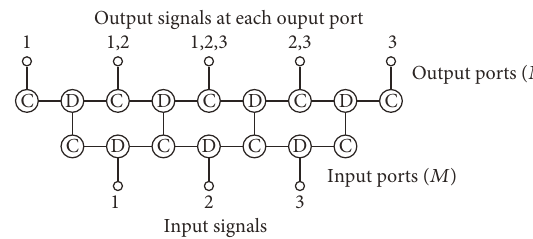
Figure 2: Diagram of a typical C-BFN topology based on basic nodes for power combination/division, which exempli fi es the shared aperture for each input